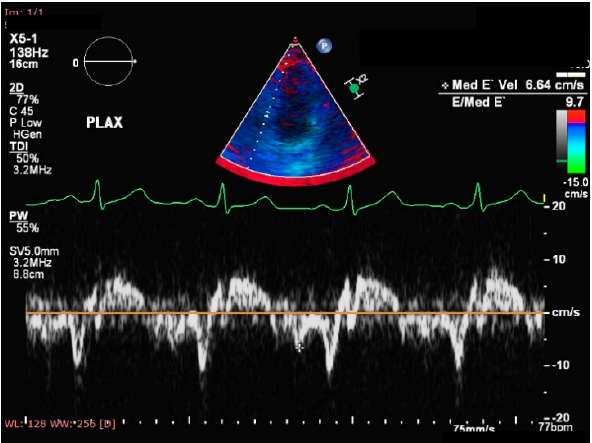
Figure 9. Tissue Doppler Echocardiography , four chamber view, tissue Doppler, estimation of LV filling pressures by measuring E/E’. Prepared by the authors. Courtesy of the Pediatric Clinical Hospital Sibiu, Lucian Blaga University of Sibiu.